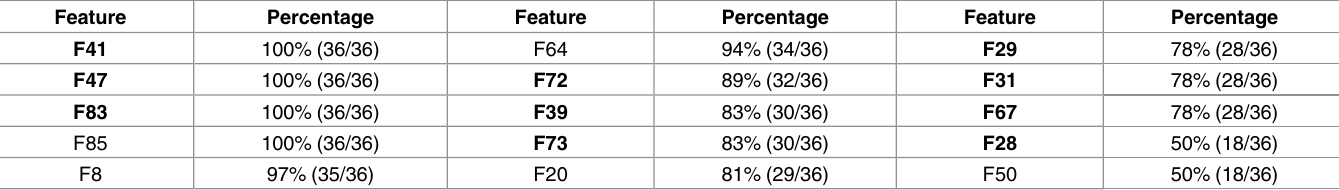
Table 4. List of 15 image features that were selected in leave-one-out training and testing cyclesto test 36 casesin the validation dataset.